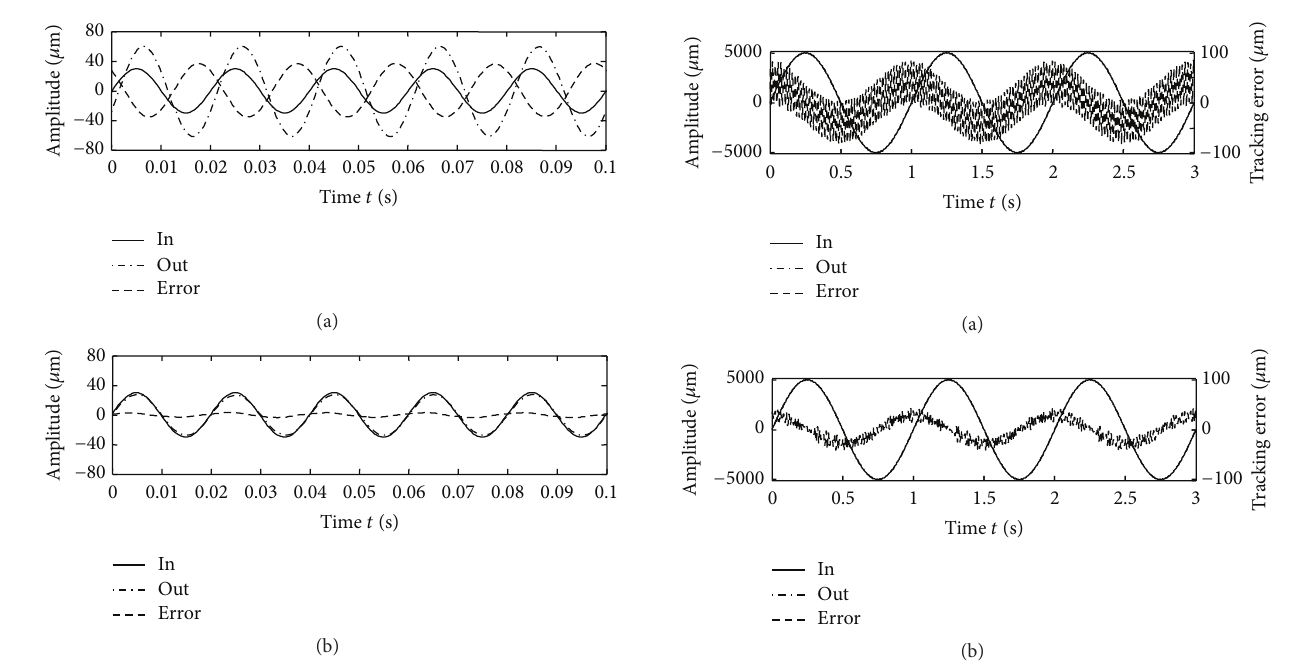
Figure 5: (a) PID 50 Hz. (b) PID + ZPETC 50 Hz.